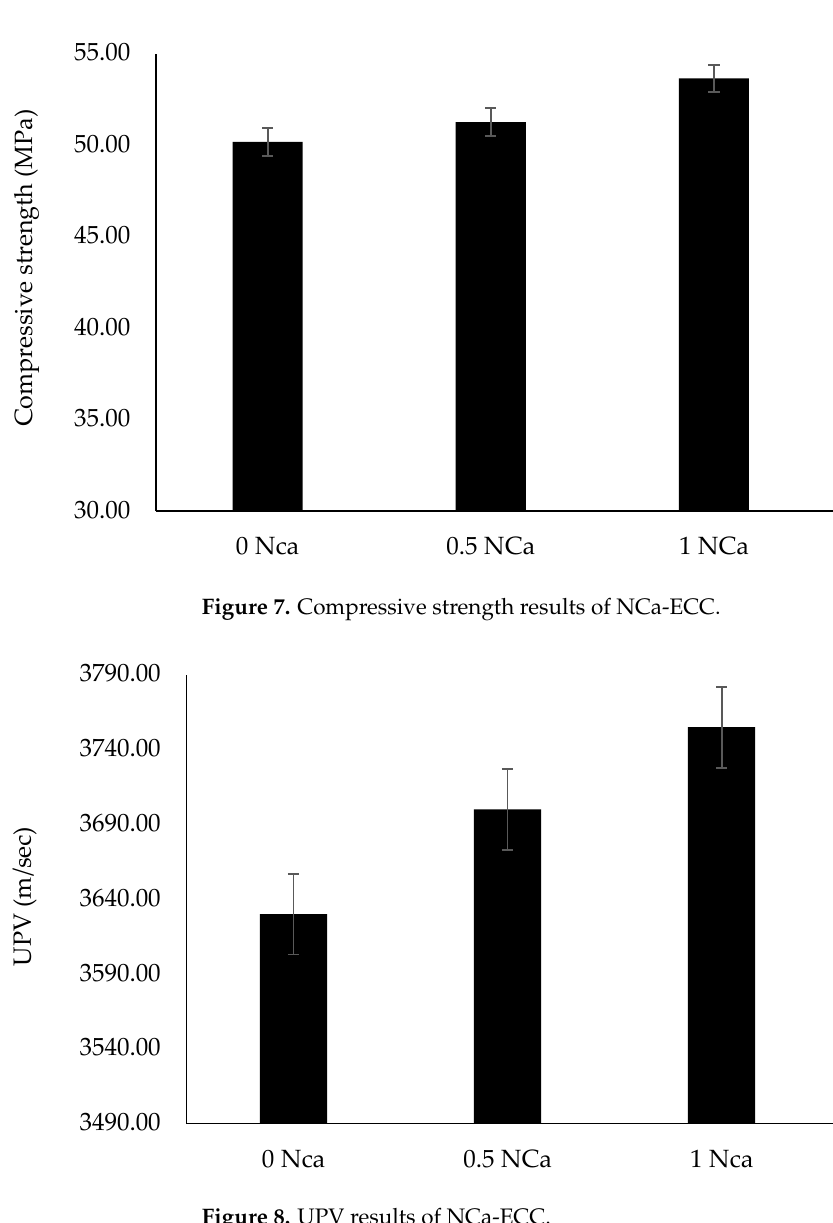
Figure 8. UPV results of NCa-ECC.